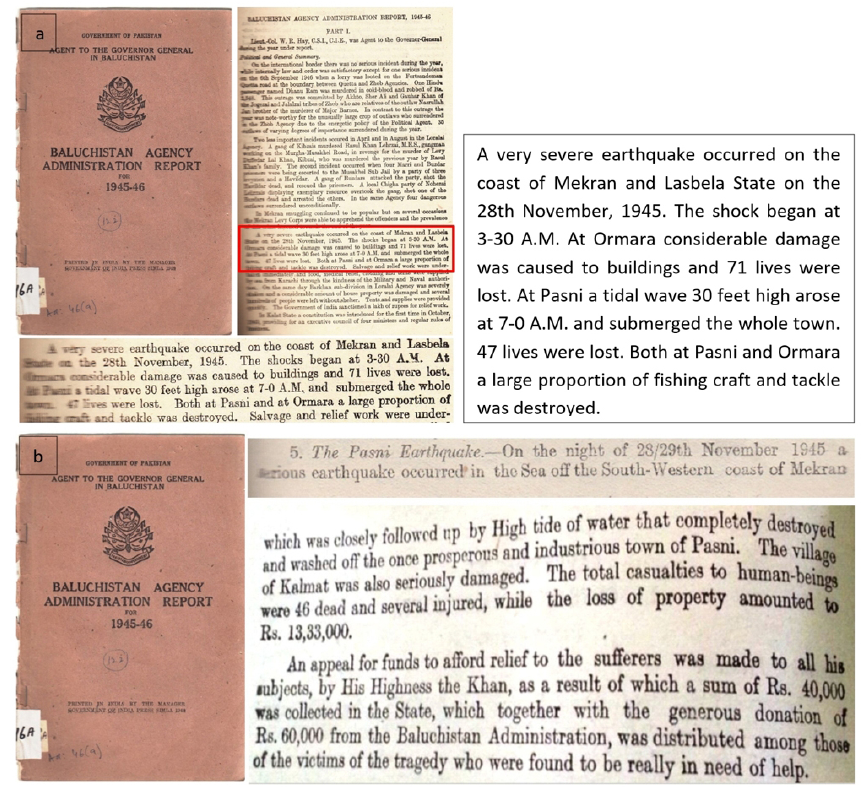
Figure 4. (a) Excerpts of Baluchistan Agency Administration Report, 1945–1946, Part I (Hay, 1948). (b) Excerpts of Baluchistan Agency Administration Report, 1945–1946, Appendix XI, pp. 59 and 60 (Hay, 1948).